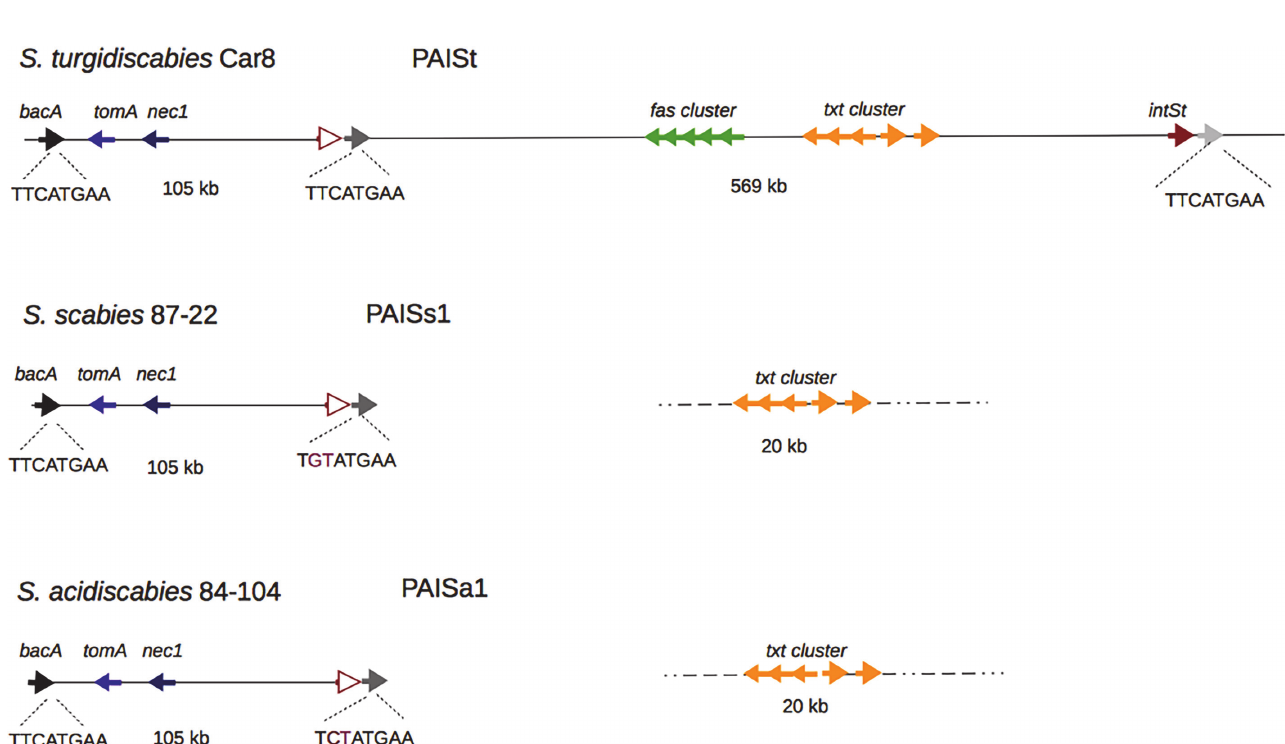
Fig 8. Relationships of PAISt with PAISs1 in S . scabies 87 – 22 and PAISa1 in S . acidiscabies 84 – 104. Islands PAISs1 in S . scabies and PAISa1 in S . acidiscabies , are integrated at the bacA 3 0 end and contain a remnant of the intSt (red line arrow) delimited by a degenerate version of the 8 bp palindrome, (mutated residues are in red). Both islands are identical to the 105 Kb module of PAISt. The thaxtomin biosynthesis cluster ( txt ) is conserved in S . scabies and S . acidiscabies but is not linked to the 105 Kb island.